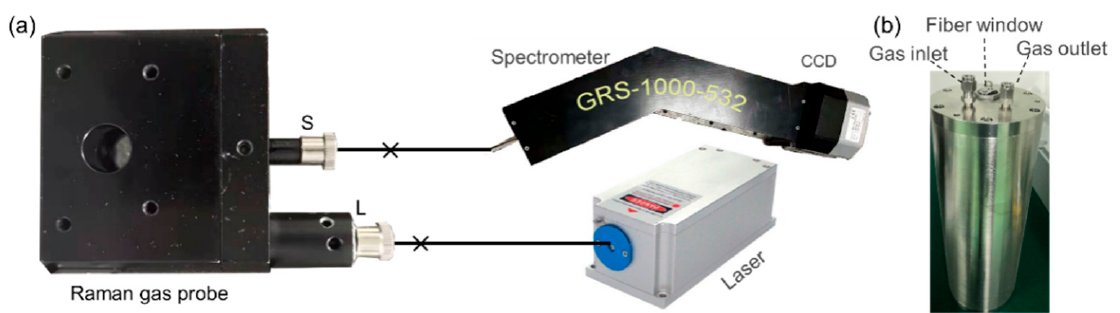
Figure 1. Diagram of the Raman probe experimental system showing ( a ) the optical setup and ( b ) the sealed stainless-steel chamber.